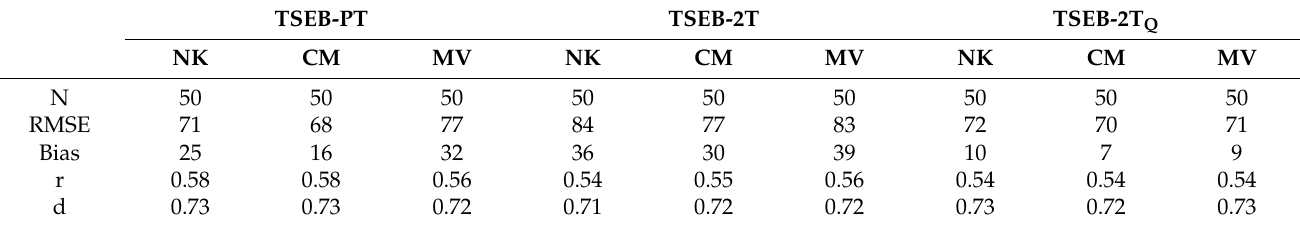
Table A6. Metrics for model evaluation shown in Figure 8. N is the number of scatters in Figure 8; RMSE is the root mean square error; Bias is the mean bias computed as the observed minus the predicted; r is the Pearson correlation coefficient between the observed and the predicted; and d is Willmott’s index of